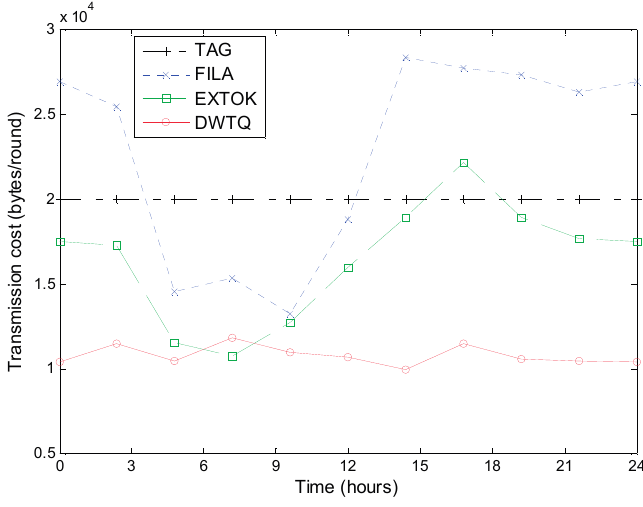
Figure 16. Transmission cost versus different time.